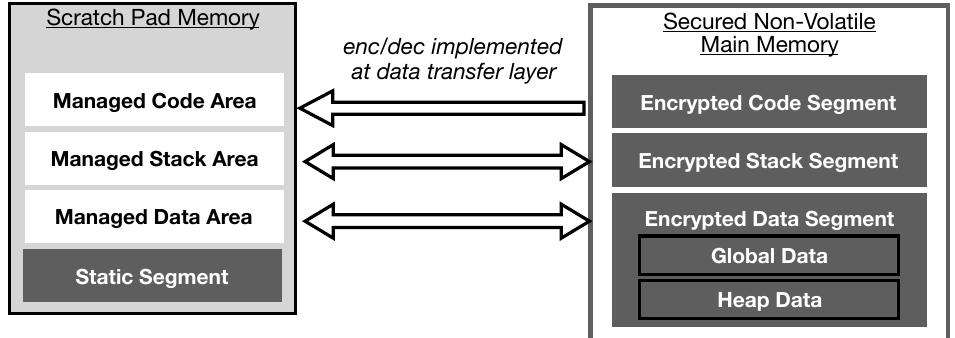
Figure 10. Secured non-volatile main memory (NVMM) using scratch pad memory (SPM) Mgt. Enc/Dec